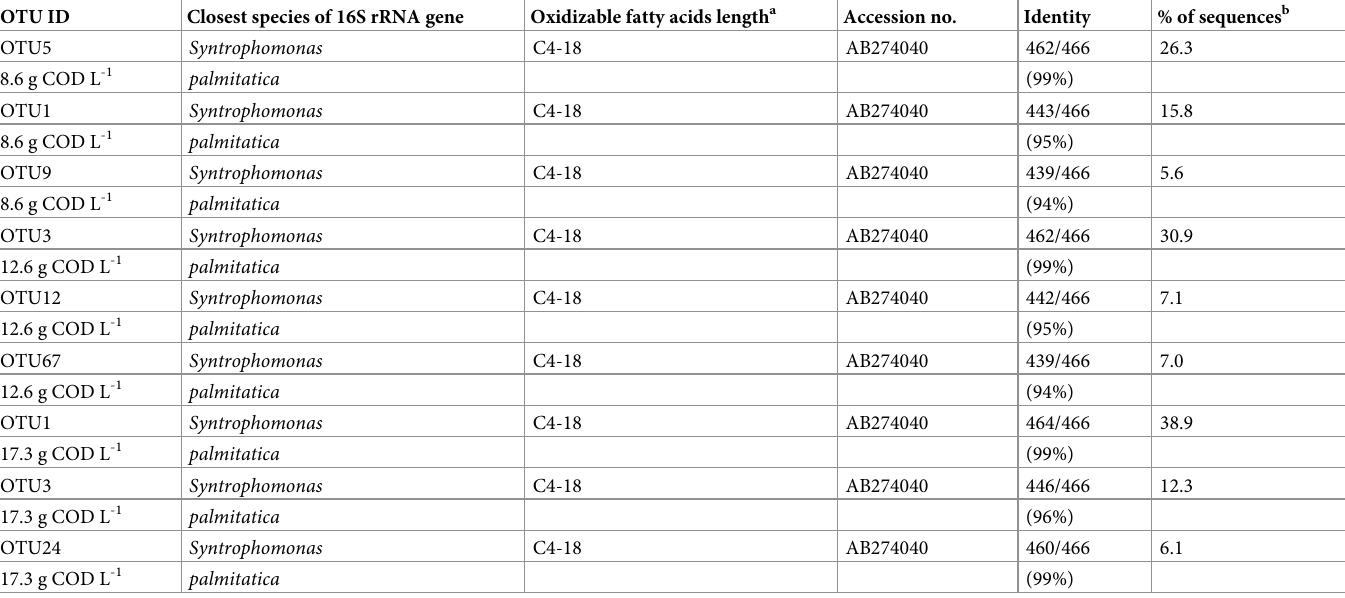
Table 4. Top 3 abundant taxa in each